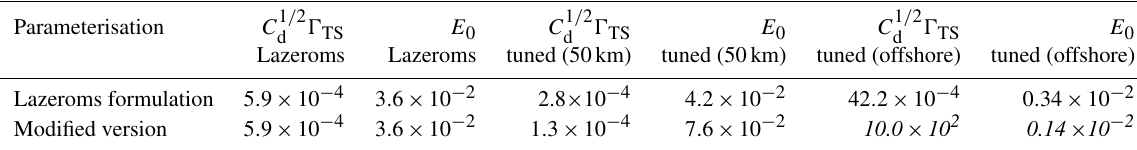
Table 6. Comparison between original (from Lazeroms et al., 2019) and best-estimate parameters tuned over the full 35 ice shelves and 127 years for the plume parameterisation. “Lazeroms” refers to the version from Lazeroms et al. (2019) and “modified” to the modified version, both presented in Sect. 2.2.2. The values in italic are subject to caution (see text).